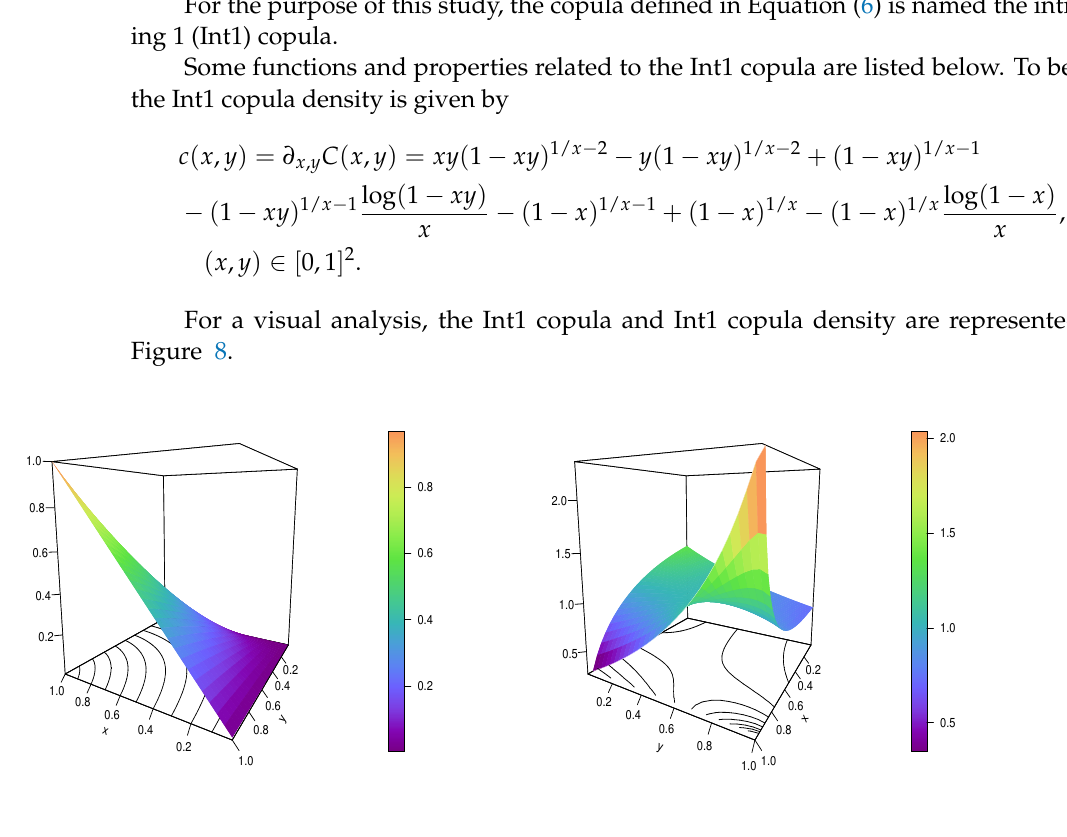
Figure 8. Plots of the Int1 copula ( left ) and the Int1 copula density ( right